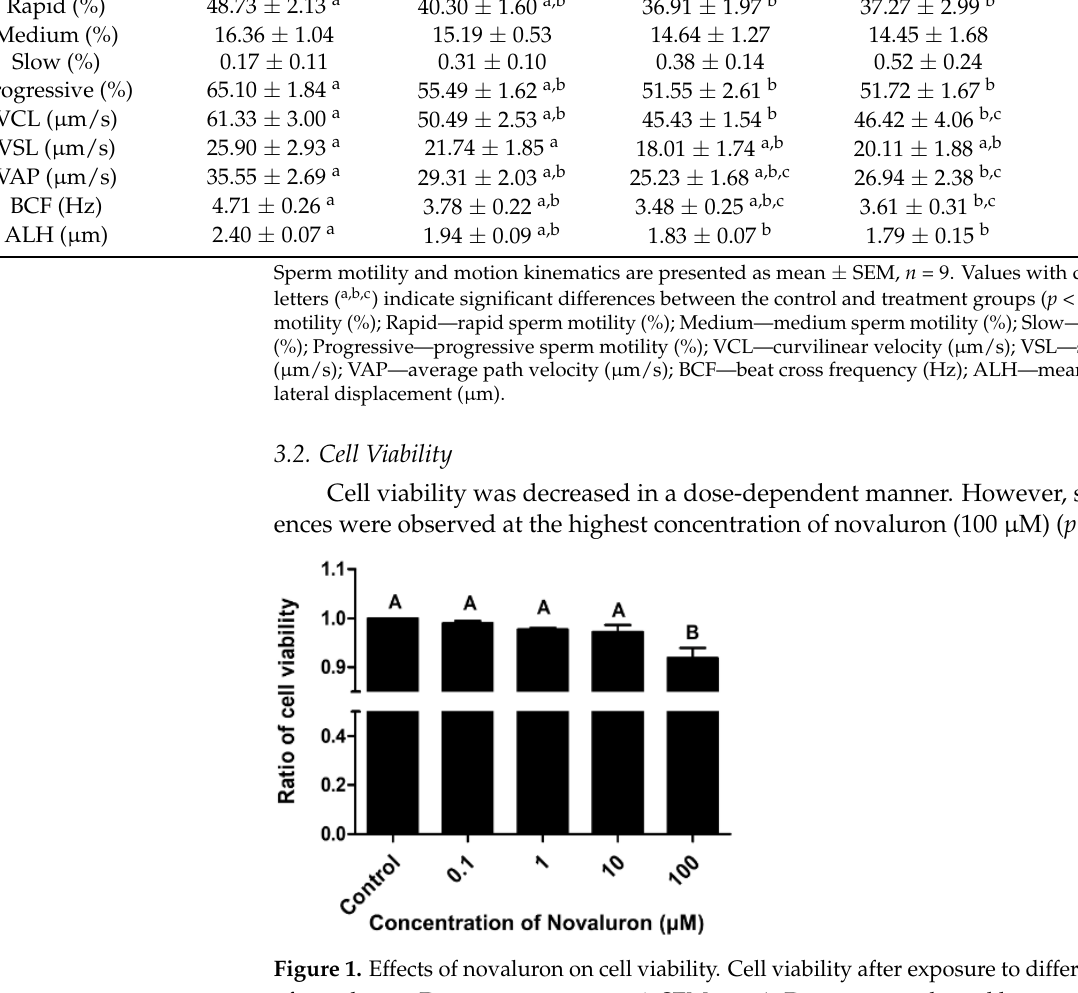
Table 1. Effects of novaluron on sperm motility and motion kinematics.